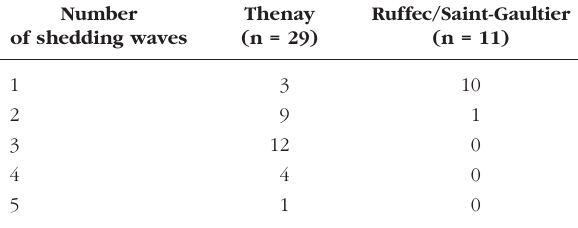
interpretation disagreed with other data noted by our team because Spanish isolates of F. hepatica miracidia, coming from cattle infections, were more infective to French populations of G. truncatula than miracidial isolates originating from central France (Gasnier et al. , 2000). A higher prevalence of F. hepatica